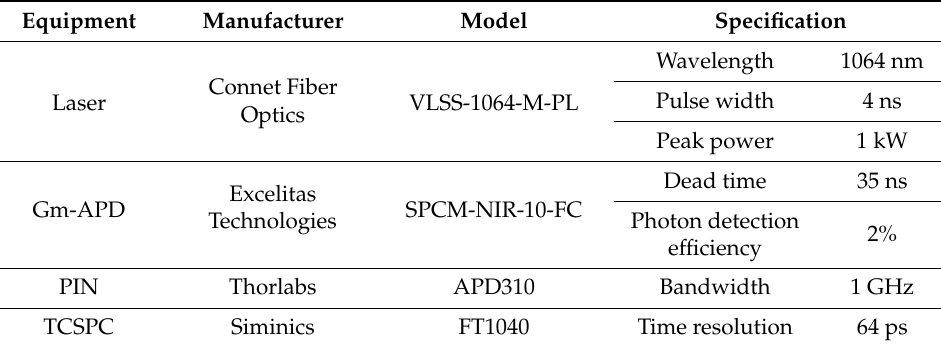
Figure 8. Experimental schematic diagram of high speed moving target detection. Table 4. Main specifications of the equipment.